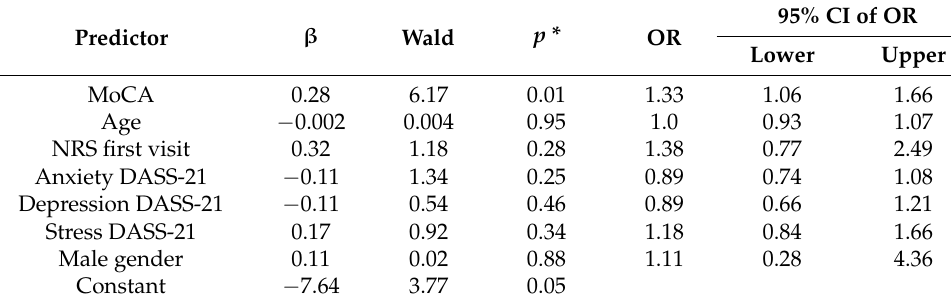
Table 3. Prediction model regarding adherence to